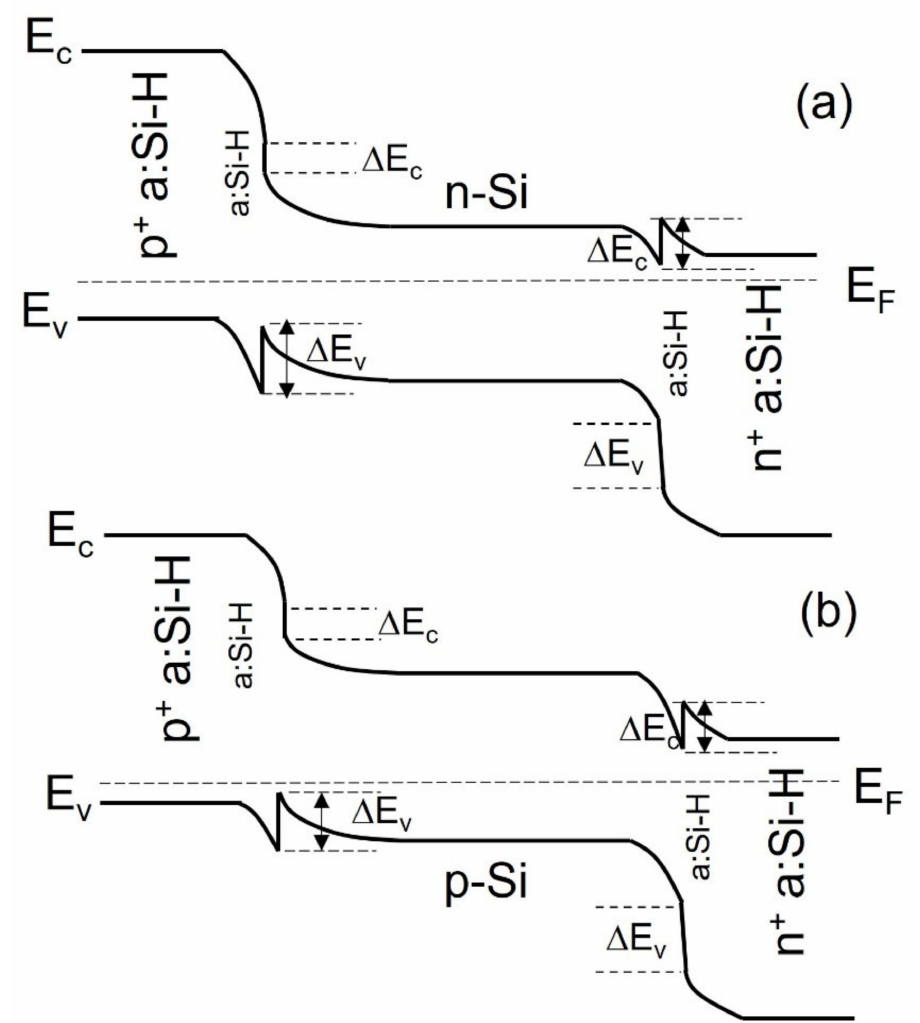
Figure 4. Schematic energy band diagram of ( a ) n-type SHJ solar cell; ( b ) p-type SHJ solar